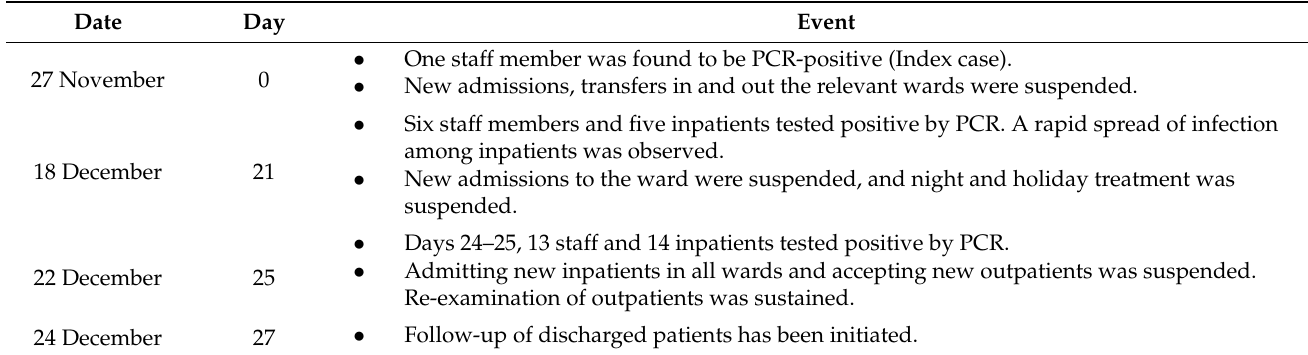
Table 5. Timeline of events at Hospital